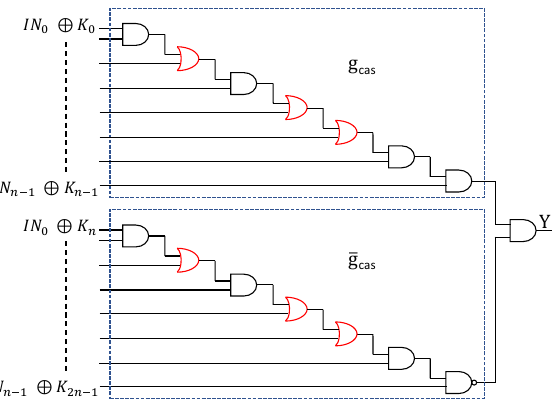
Figure 3: One possible instantiation of CAS-Lock (Note that g and ¯ g are still symmetric and